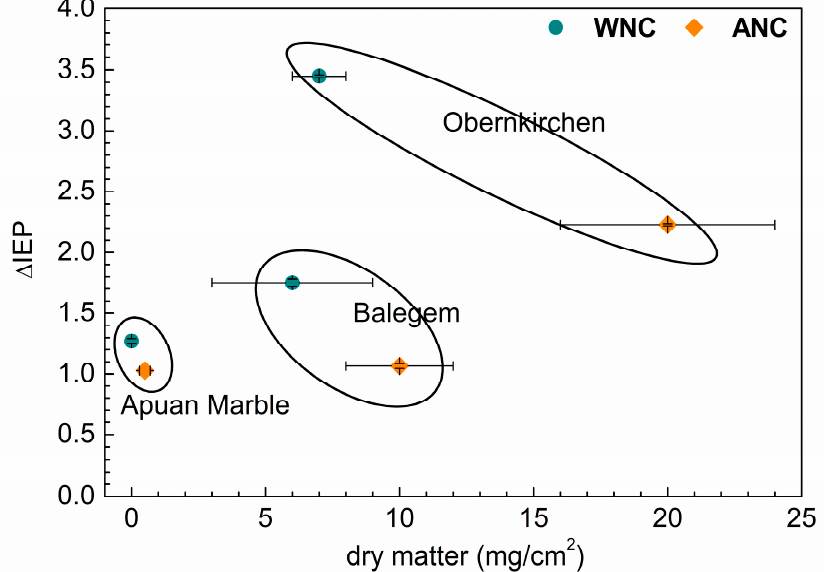
Figure 4. Correlation between dry matter (mg/cm 2 ) and Δ IEP (Equation (2)) for lithotypes after treatment with WNC/ANC.